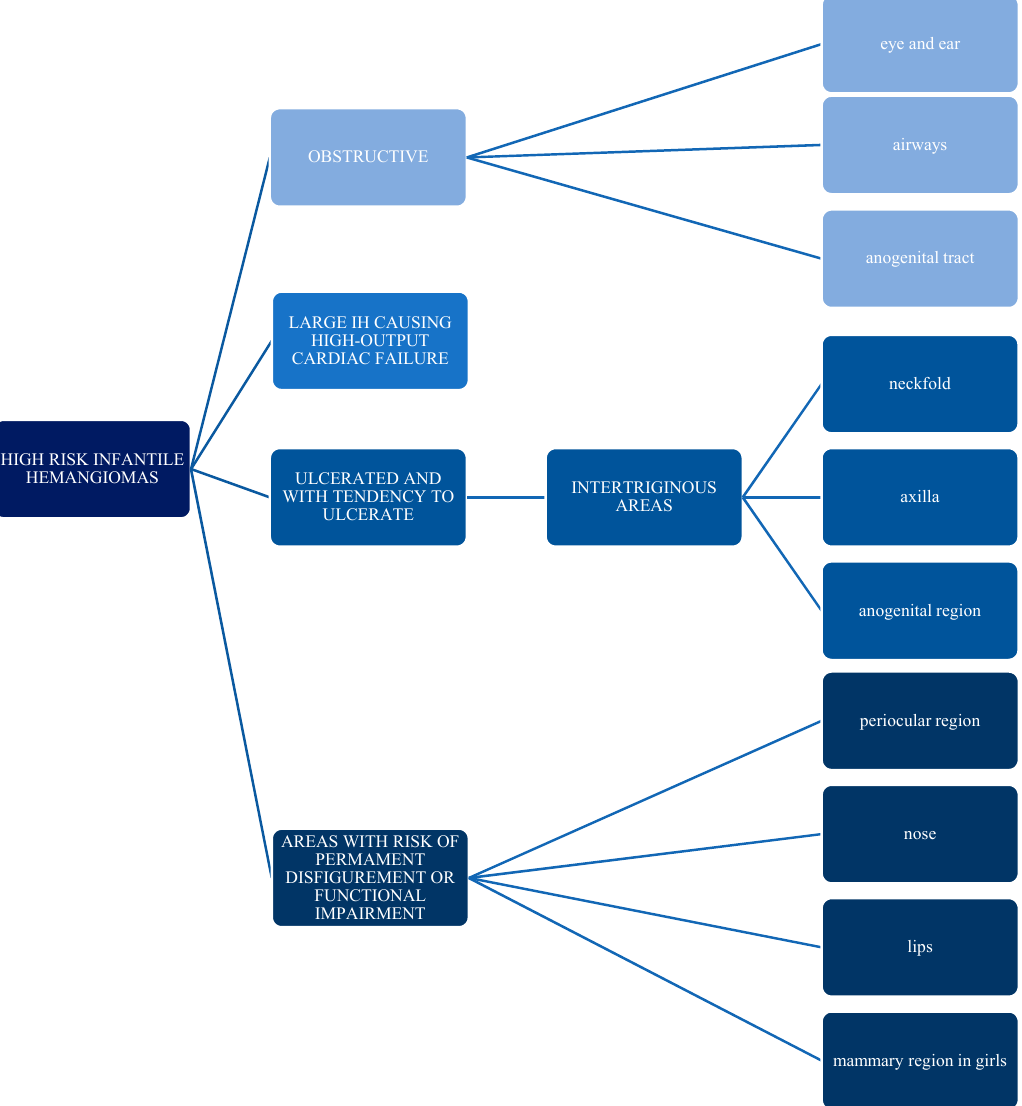
Figure 1. Characteristics of infantile hemangiomas with a high risk of complications.